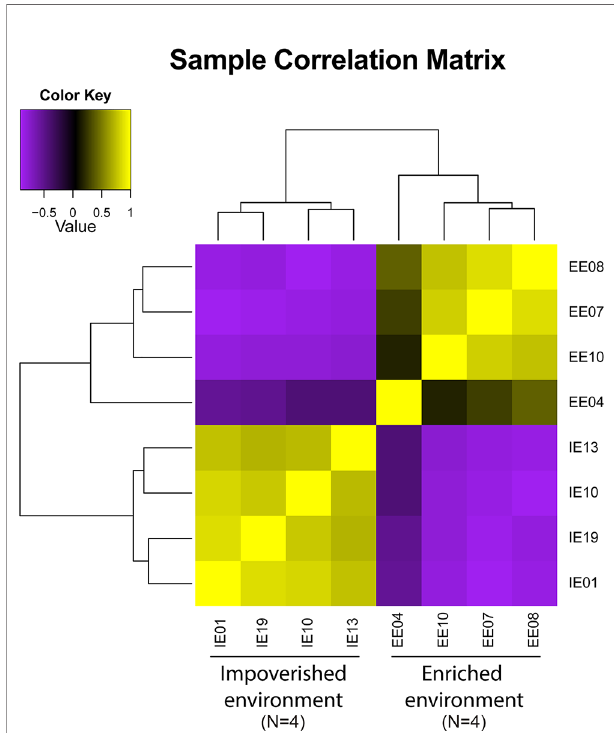
FIGURE 8 | Sample correlation matrix from eight individuals subjected to neurotranscriptome analysis [four from the impoverished environment (IE) and four from the enriched environment (EE)], showing signi fi cant levels of coherent clustering between the brain samples of Colossoma macropomum raised in contrasting